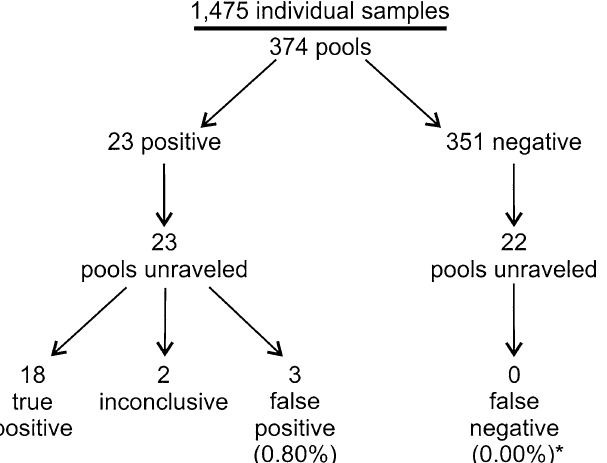
Figure 5. Results of routine use of the screening test; asterisk: false negative ratio calculated only from unraveled negative pools (which include 88 individual